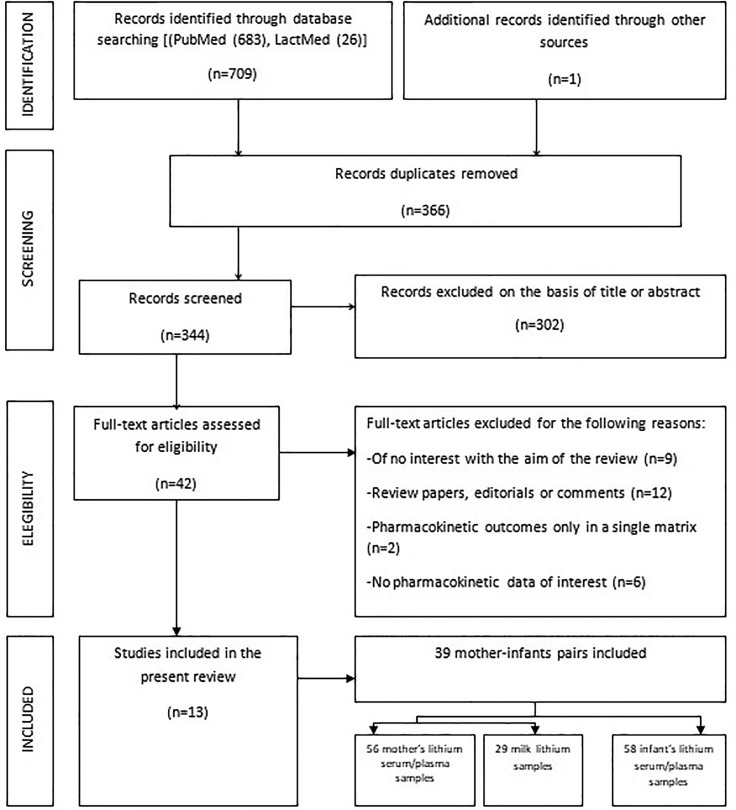
Flowchart of considered and finally selected studies, according to the PRISMA statements.